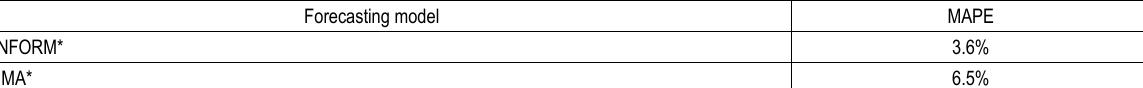
Fig. 5. Day-ahead price forecasting results for the studied period Table 3. Price forecasting m odel’s performance